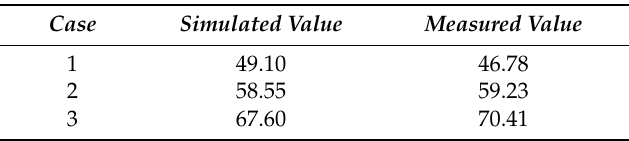
Table 7. Average level of the emitted electric field (in dB · µ V/m) at a distance of 3 m from the IC, for the three different operating conditions of the IC defined in Table